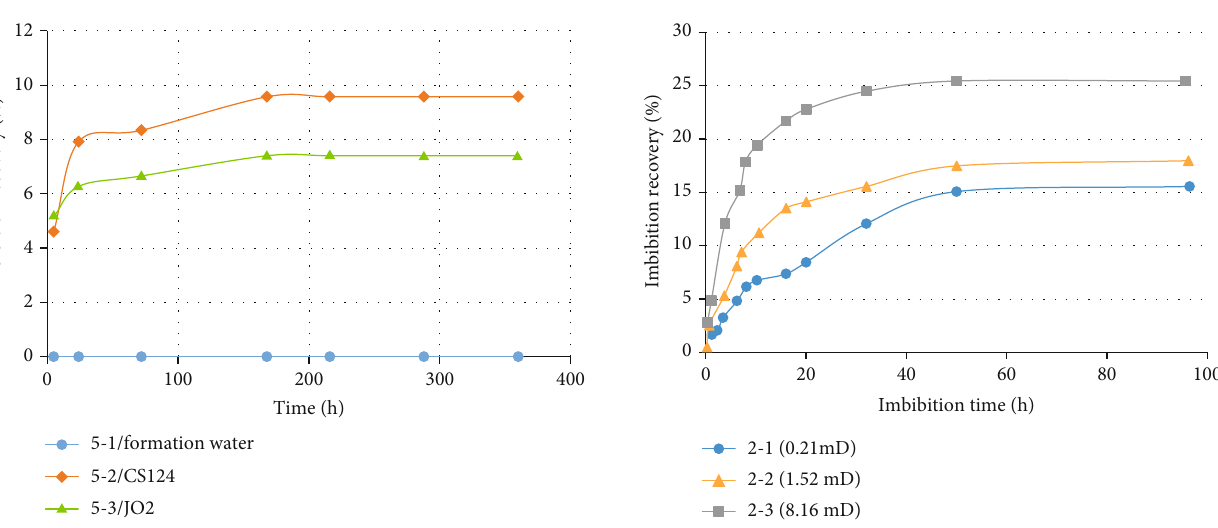
Figure 9: In fl uences of permeability on imbibition